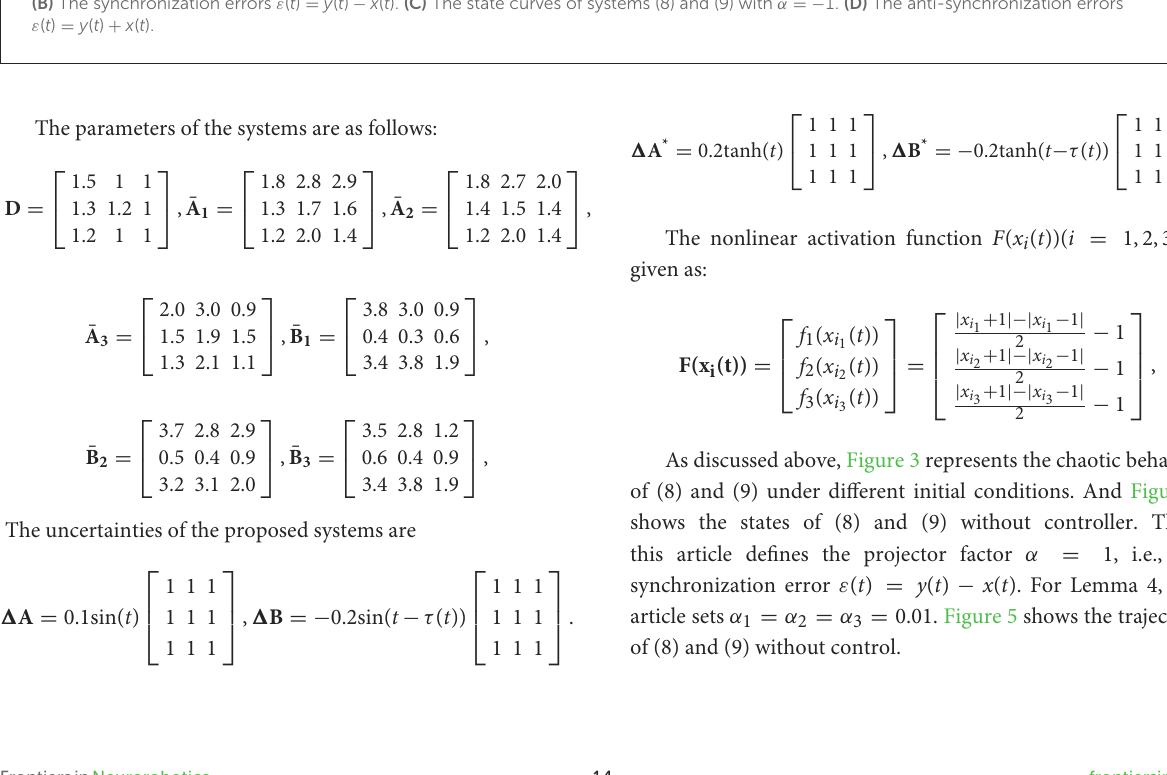
y ( t ) x ( t ). (C) The state curves of systems (8) and (9) with α = −